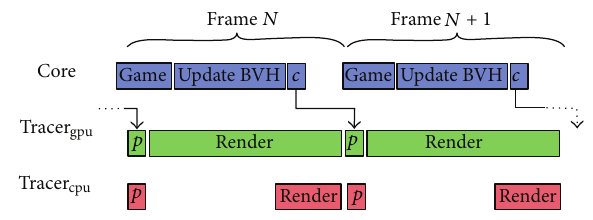
Figure 7: Double buffering the BVH. The CPU updates the BVH and sends changes to the tracers. Each tracer processes the changes in a commit buffer before rendering the next frame.